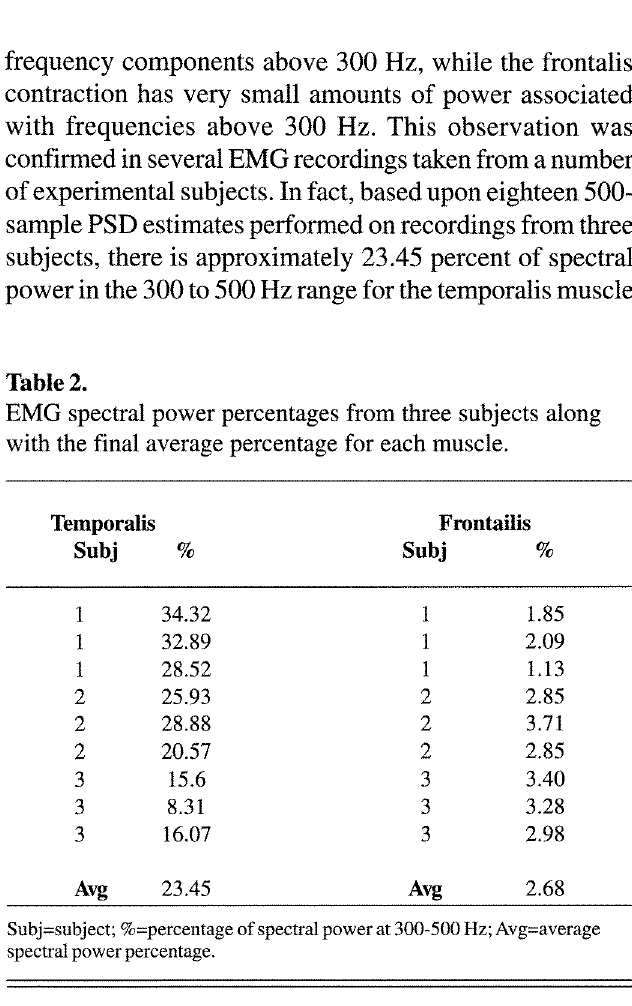
500-sample PSD performed on an EMG recording from the left temporalis muscle using electrode E 1